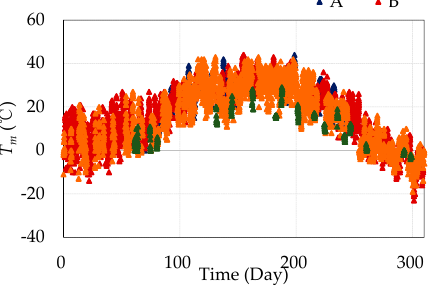
Figure 6. Actual data of PV module temperature in the whole year.